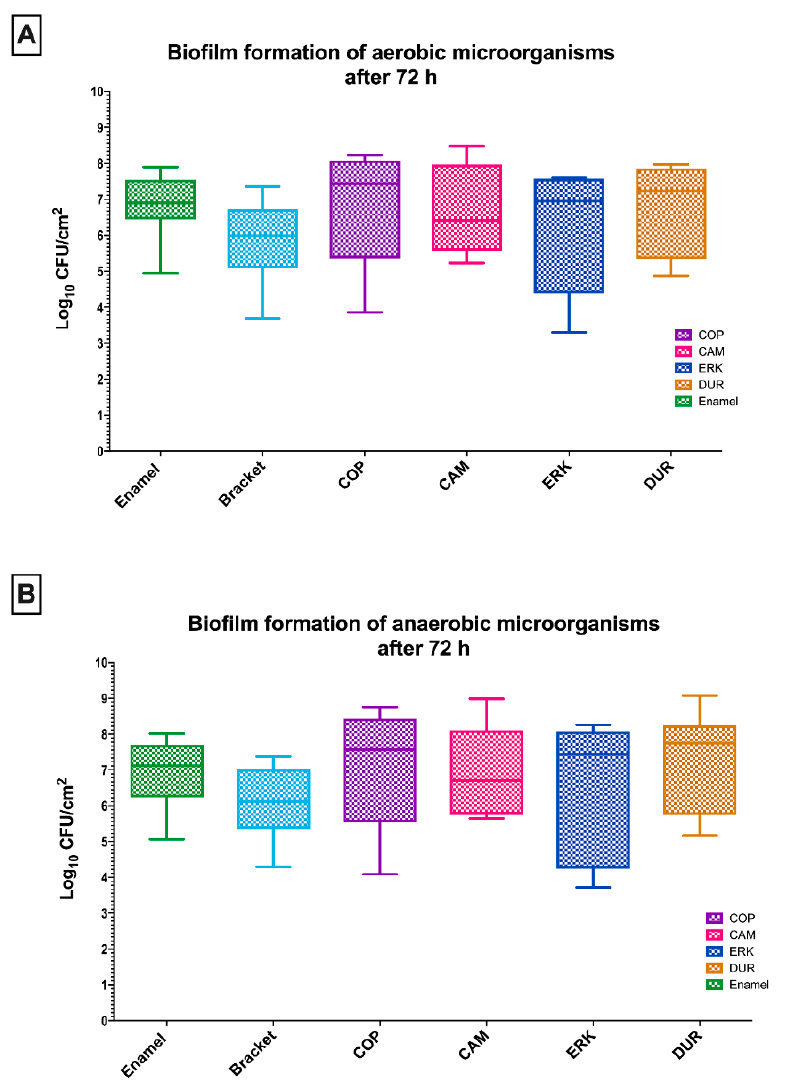
Figure 2. Boxplots depicting the colony-forming units (CFUs) of aerobic ( A ) and anaerobic ( B ) microorganisms on the tested aligner and control surfaces after an incubation time of 72 h. The medians, whiskers, and max/min outliers are demonstrated. Four different aligner materials were tested: CA-medium (CAM), copolyester (COP), Duran (DUR), Erkodur (ERK). Bovine enamel and metal brackets served as control groups.